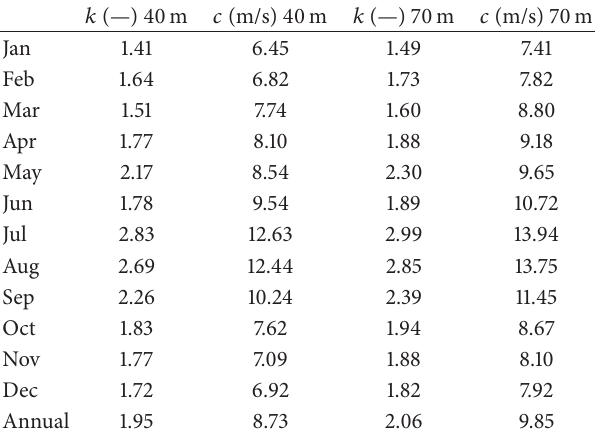
Figure 6: Total monthly energy output from selected wind turbines at Jarandagh